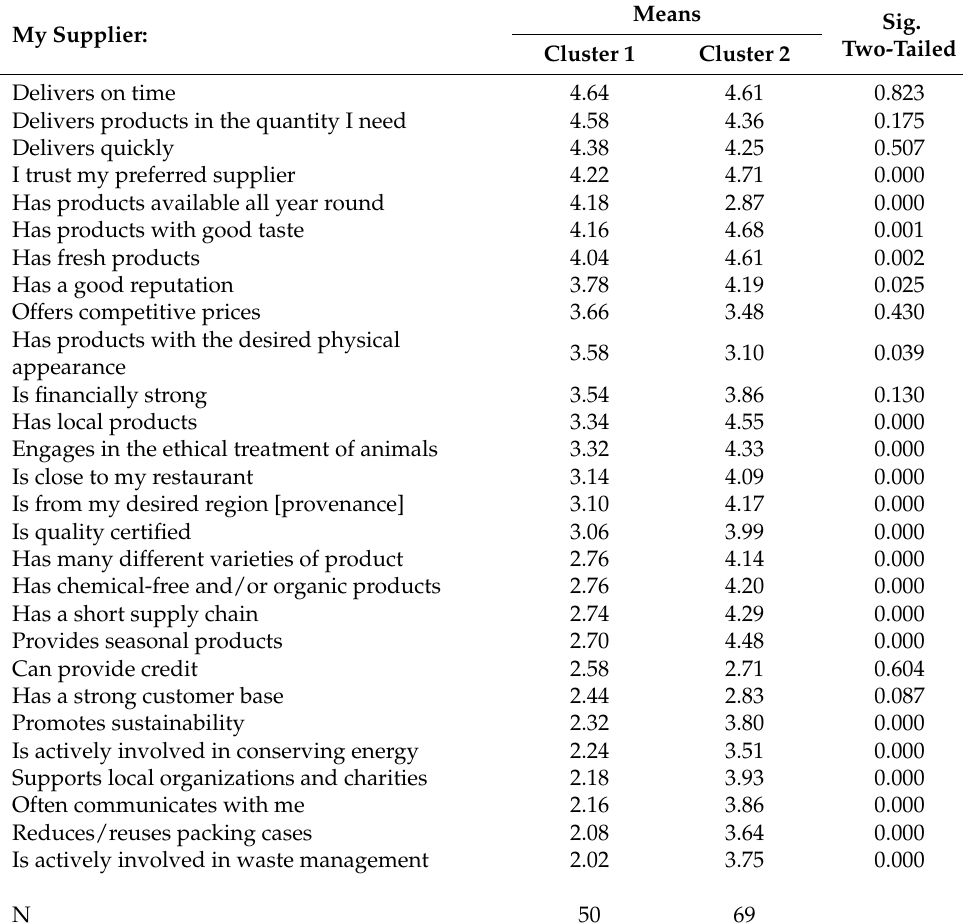
Table 2. Importance of supplier purchasing criteria by